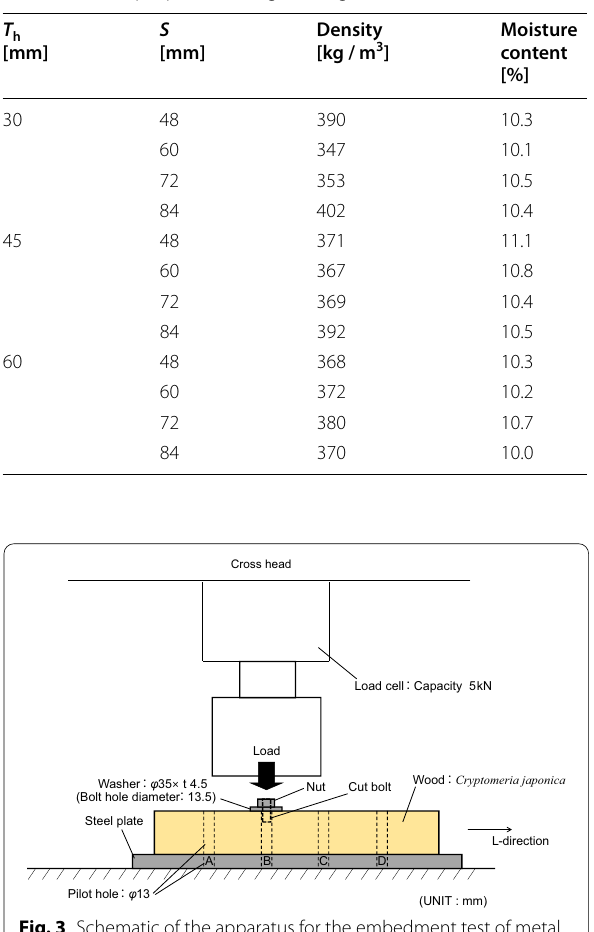
Table 1 Basic properties of tightening test materials